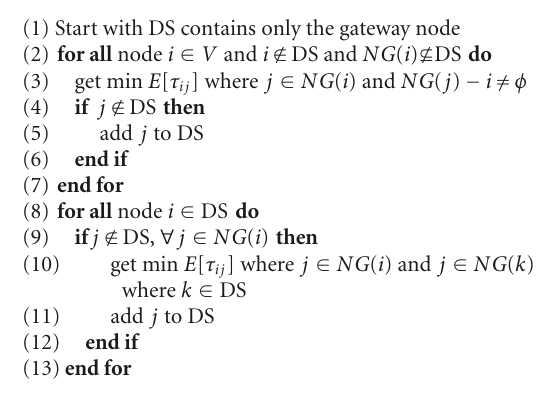
Algorithm 2: Calculating the dominating set (DS) based on node intermeeting